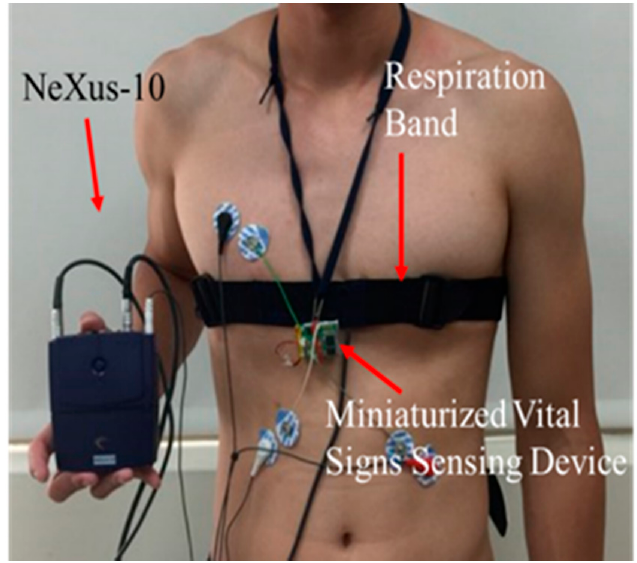
Figure 6. Device setup of experiment for algorithm validation. The respiration sensor is a belt set included in the NeXus-10, which also records ECG signals.